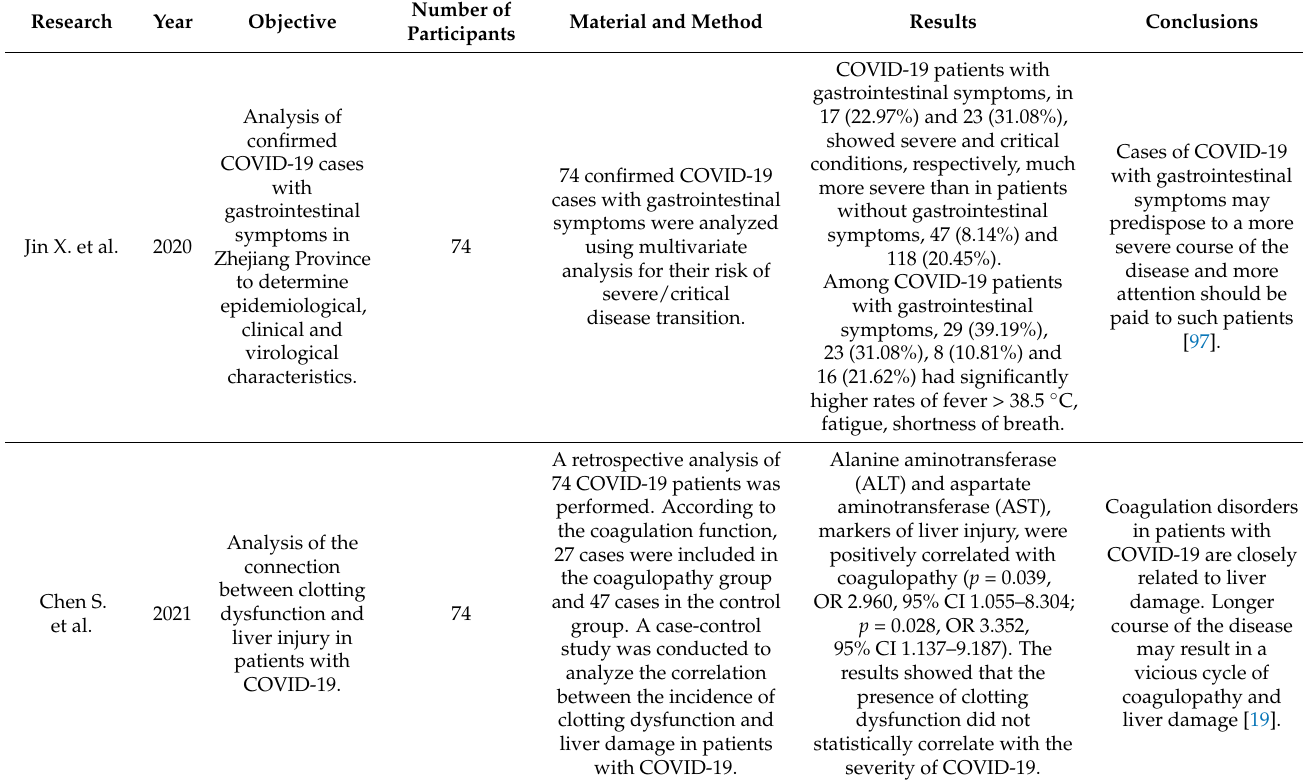
Table 7. The main effects of COVID-19 on the digestive